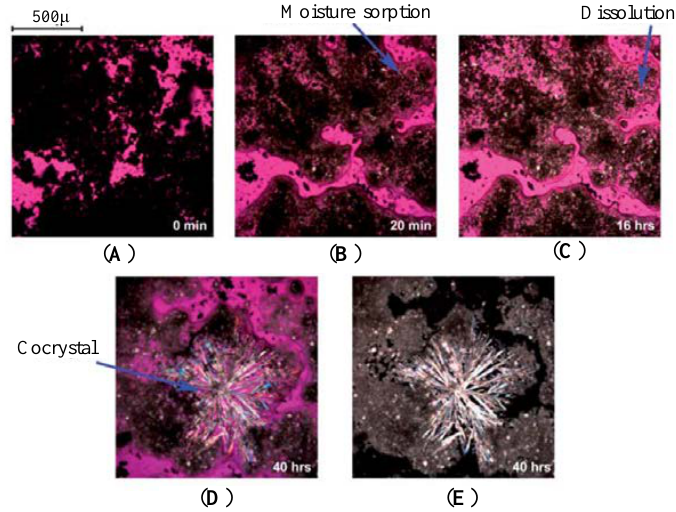
Figure 10. Schematic representation of cocrystal formation by moisture uptake in presence of a deliquescent additive [Reprinted from [159] with permission. Copyright 2007 American Chemical Society].